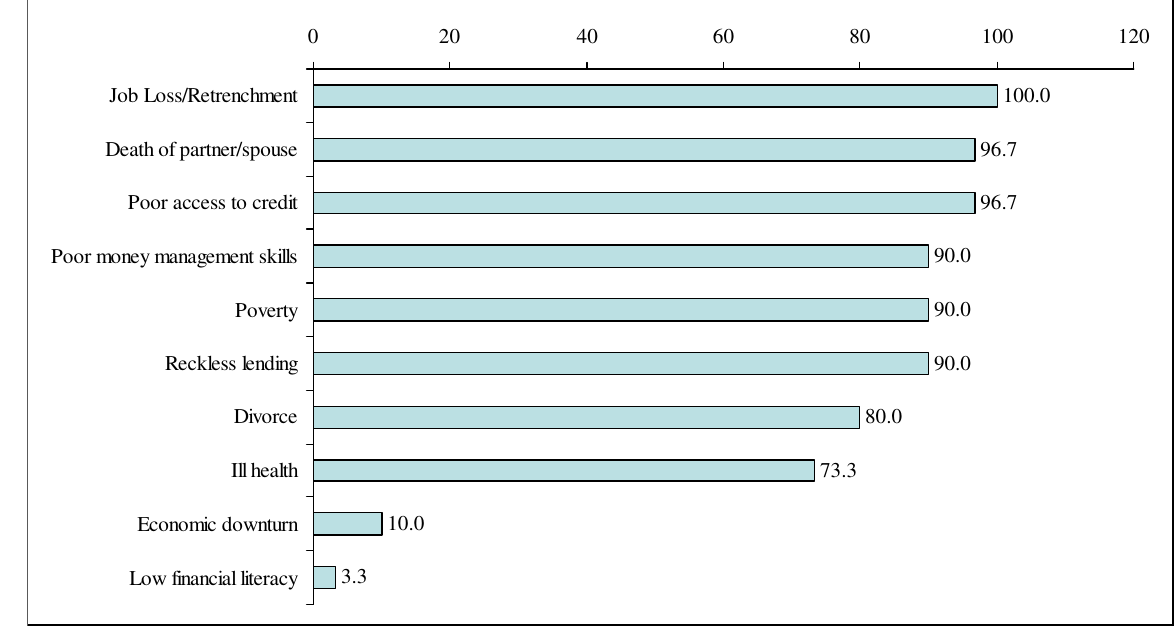
Fig. 1. Drivers of consumer over-indebtedness in